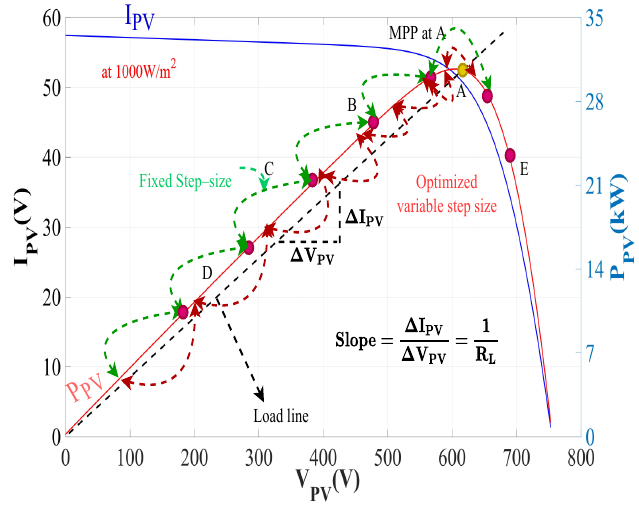
Figure 5. Variable and fixed step size MPPT operation.